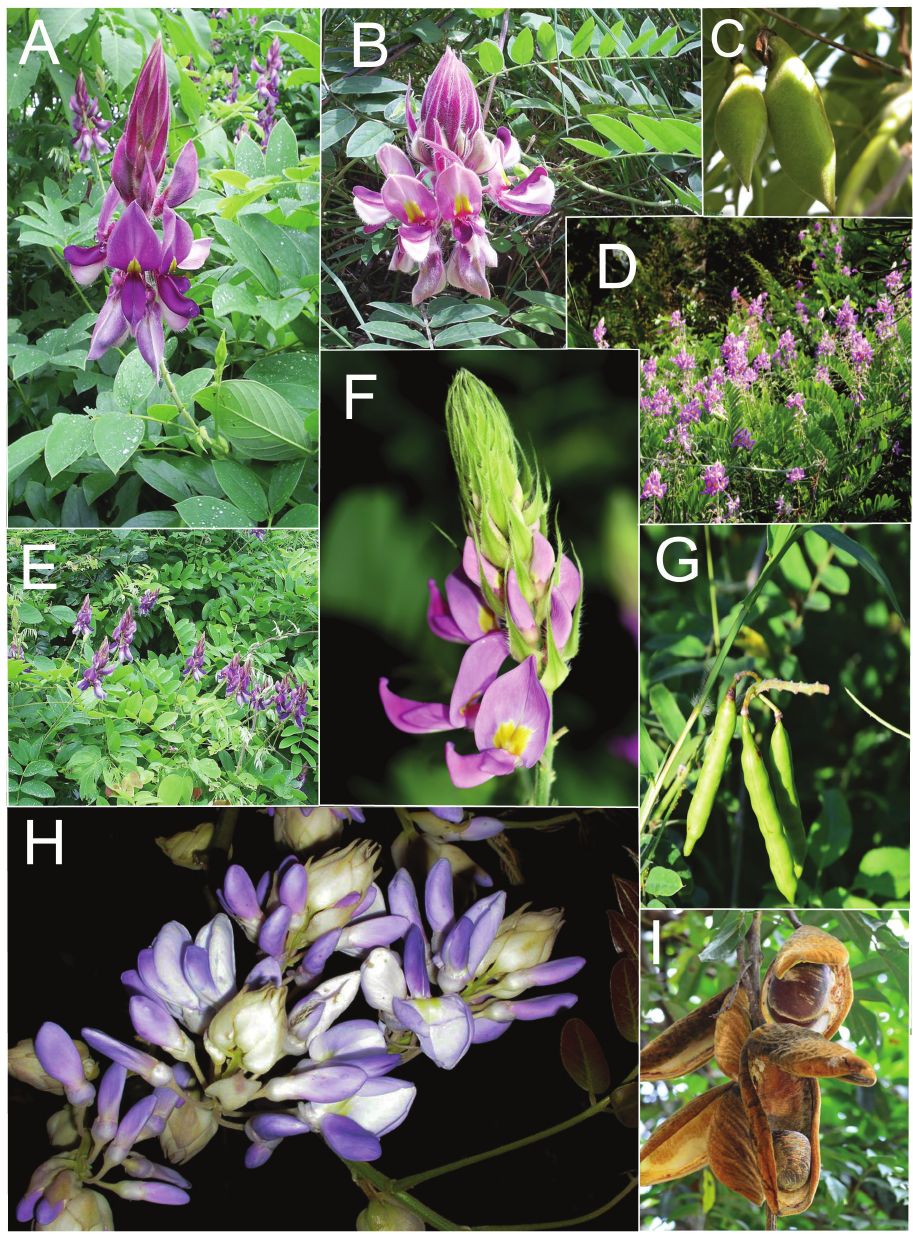
Plate 2. Afgekia, Sarcodum and Padbruggea . A Afgekia mahidoliae, Thailand, Sai Yok distr. Kanchanaburi, Y.Sirichamorn s.n. B, C Afgekia sericea Thailand S.Mattapha 1158 D Sarcodum scandens Vietnam, Quang Binh Prov. Lôc & Quang P11554 E Afgekia mahidiliae Thailand, Sai Yok distr. Kanchanaburi Y.Sirichamorn s.n . F Sarcodum scandens Vietnam, Quang Binh Prov. Lôc & Quang P11554 G Sarcodum scandens Laos, Sop Teuang, Bolikhamxai Prov. S.Lanorsavanh 1299 H, I Padbruggea filipes Thailand, Chi- ang Mai, Y.Sirichamorn & S.Mattapha YSM2017-1